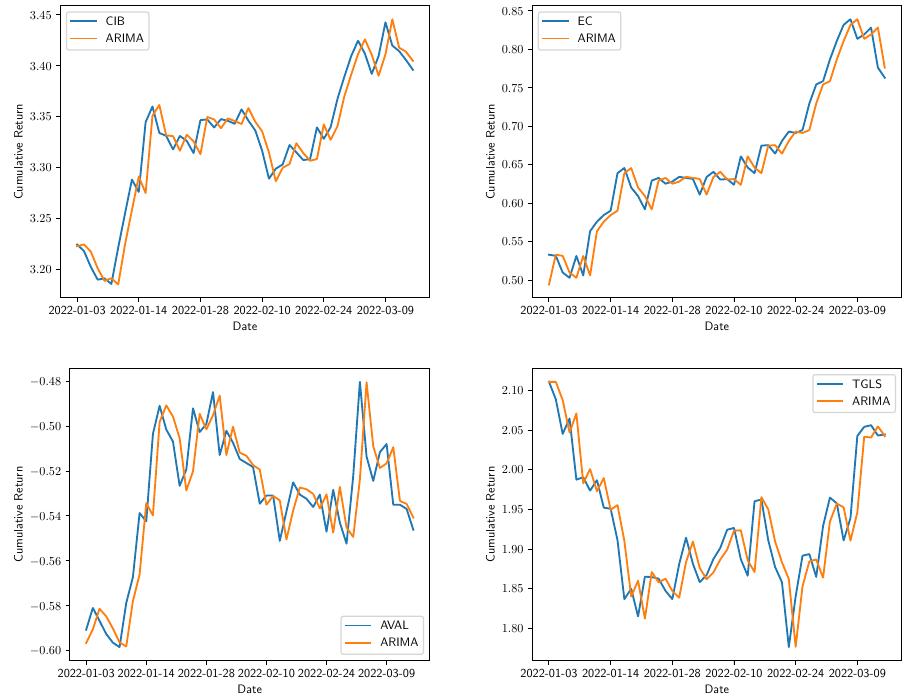
Figure 4. Real vs. ARIMA adjustment for cumulative returns of Bancolombia, Ecopetrol, Grupo AVAL, and Tecnoglass. The real time series is represented by the share symbol and its prediction with the model name in the